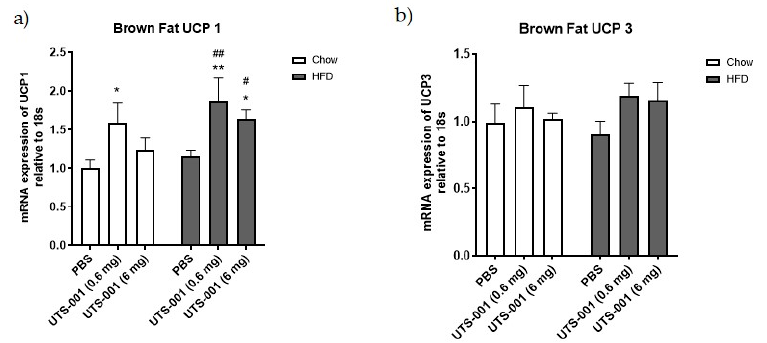
Figure 5. mRNA expression of ( a ) CPT-1a; ( b ) ATGL; ( c ) PPAR γ in the fat. Results are expressed as